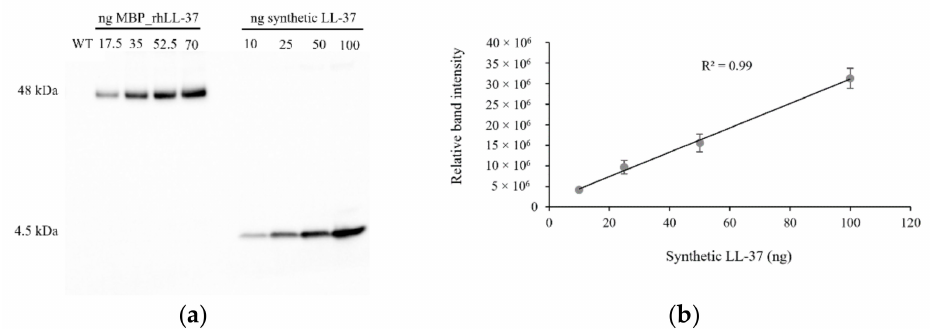
Figure 3. Quantification of the MBP_rhLL-37 fusion protein. ( a ) Immunoblot analysis of crude extracts of lyophilized samples from transgenic T6 field-grown barley plants expressing endosperm- targeted fusion protein MBP_rhLL-37 in the late milk endosperm seeds with LL-37 specific antibody; WT, wild type (non-transformed plant). ( b ) The calibration curve of synthetic LL-37 peptide was used for semiquantitative estimation.